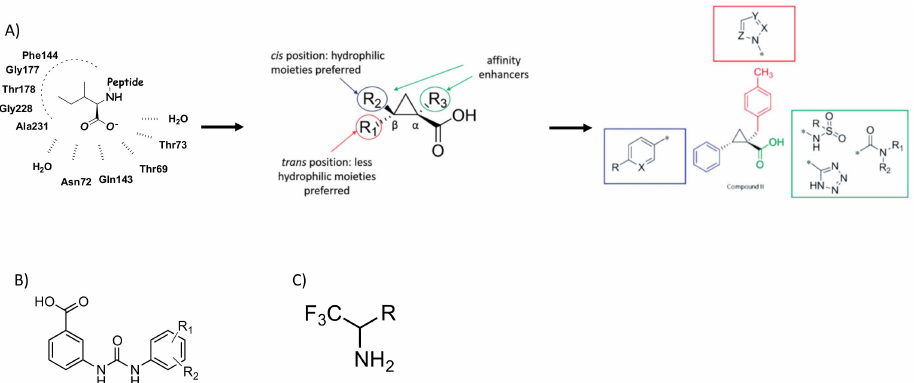
Figure 7. O -Acetylserine sulfhydrilase (OASS) inhibitors discussed in this review. ( A ) schematic representation of the rational design of the first sulfhydrylase inhibitors based on the structural features of the OASS–SAT interaction; ( B ) chemical sca ff old of potent inhibitors of CysM, enzyme in cysteine biosynthesis during mycobacterium dormancy; ( C ) chemical sca ff old of fluoroalanine derivatives endowed with the ability to irreversibly inhibit both OASS-A and B